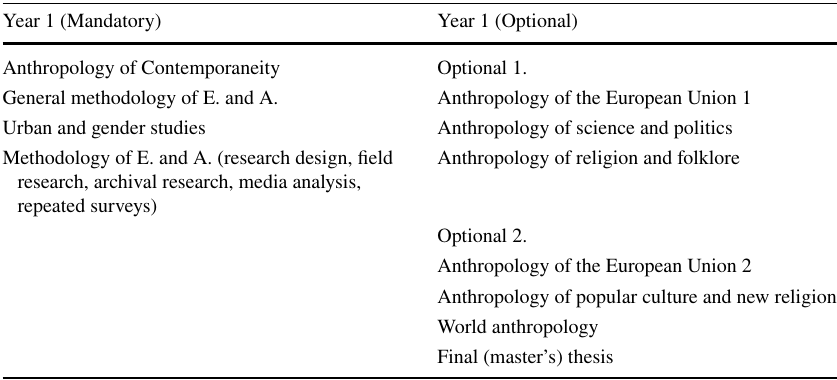
Table 2 Curriculum for a one-year master’s program Year 1